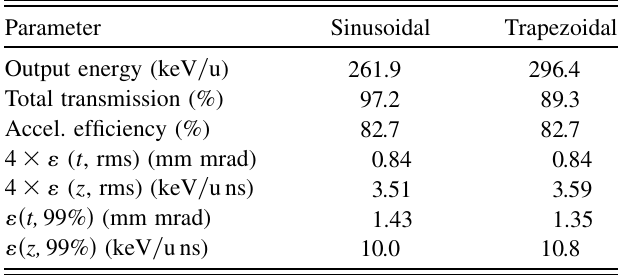
TABLE V. Comparison between the original sinusoidal and final trapezoidal modulation design for the ATLAS upgrade RFQ for the same power and length.